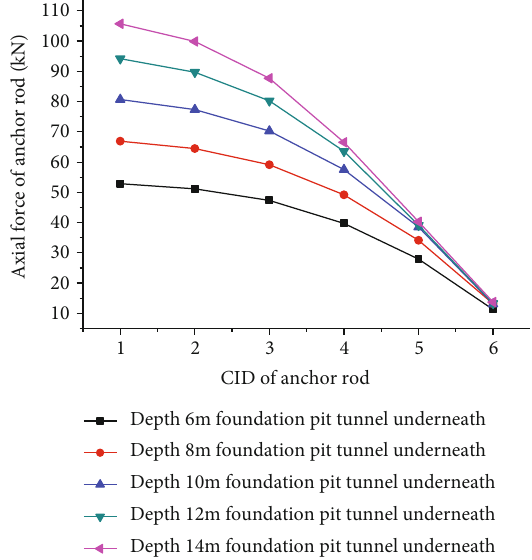
Figure 9: Variation curve of axial force of each member of anchor bolt at the top of tunnel with foundation pit depth under 20 m wide foundation pit.